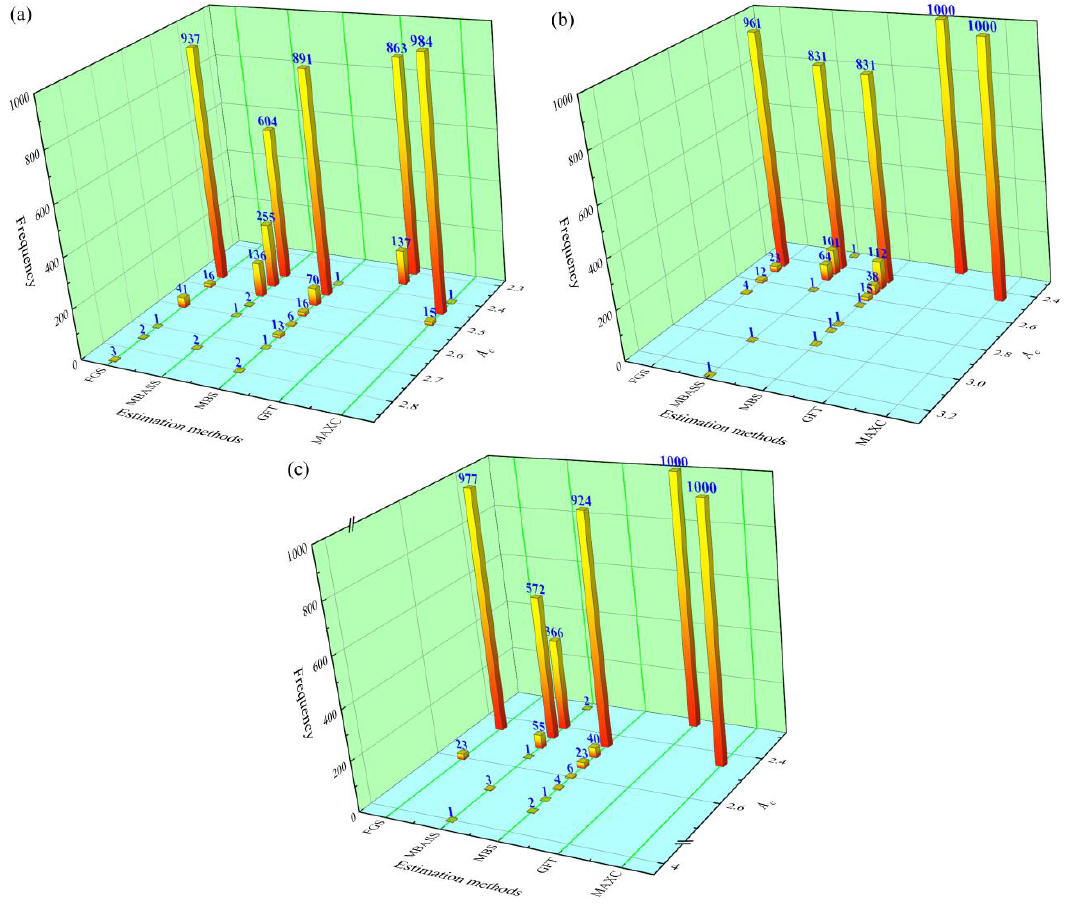
Figure 4. Estimation A c of 1000 Bootstrap samples of five methods with three data volume at ( a ) 10,000, ( b ) 50,000, and ( c ) 100,000.